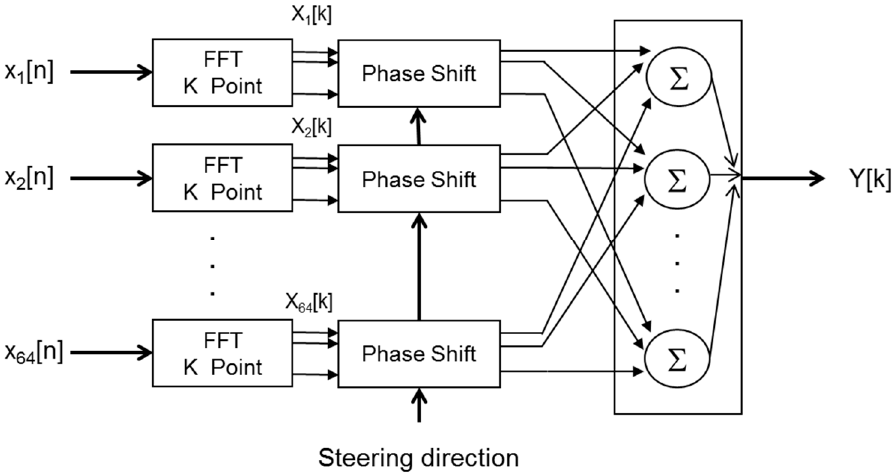
Figure 5. Wideband Figure 5. Wideband beamforming. Figure 5. Wideband beamforming.